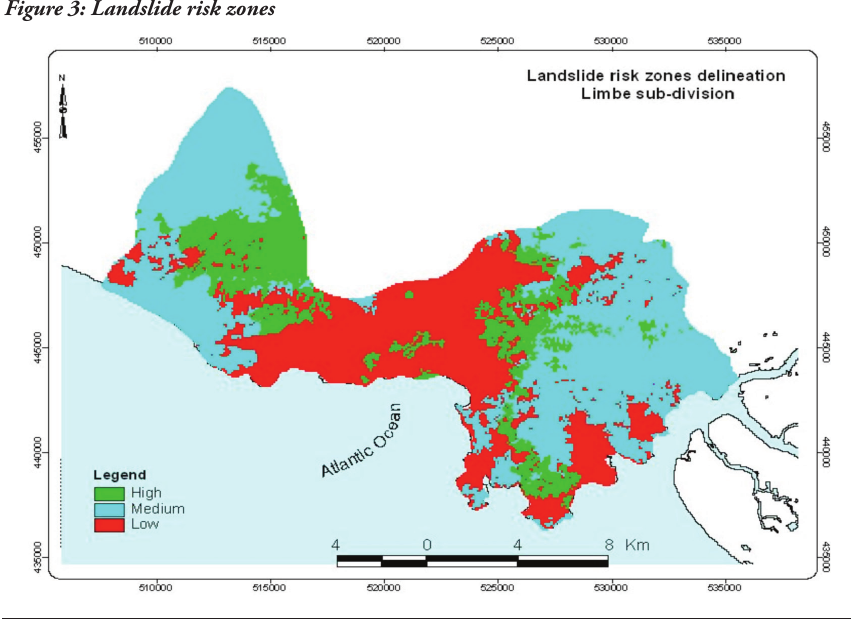
Table 2: Landslide parameters around the city of Limbe